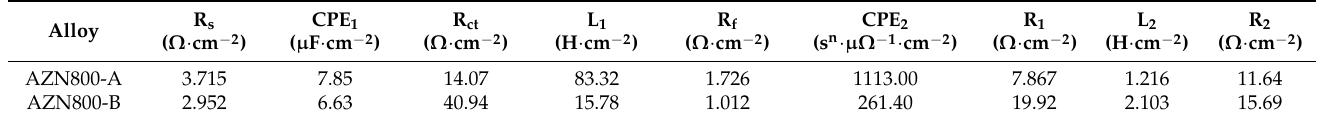
Table 3. Fitting results of the EIS spectra of the AZN800-A and AZN800-B alloys.